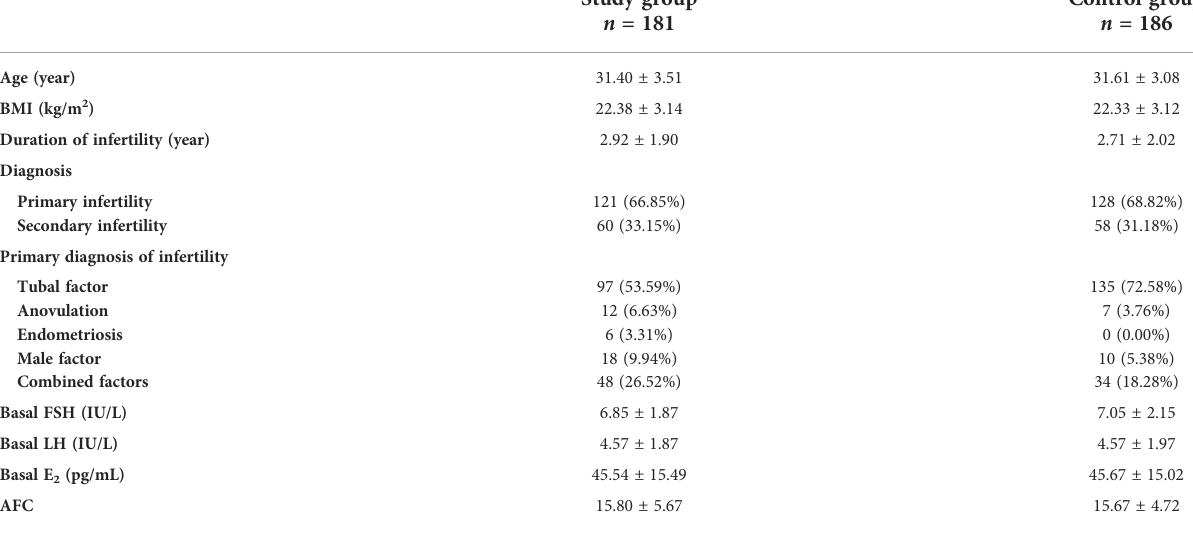
TABLE 1 Baseline characteristics of the intention-to-treat